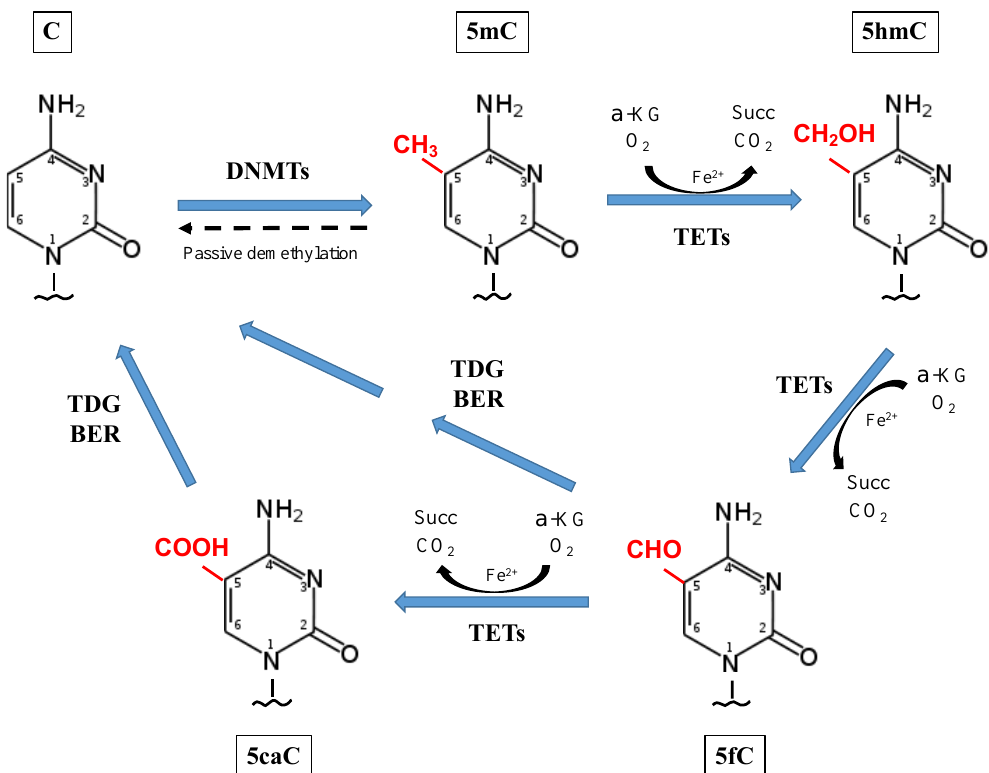
Figure 2. DNA methylation and demethylation in mammalian cells. DNA methylation occurs at the C5 position of cytosine (5mC), mostly in the context of CpG dinucleotides. 5mC is converted to 5-hydroxymethylcytosine (5hmC) by a DNA methylcytosine dioxygenase, belonging to the ten-eleven translocation (TET) family. TET proteins, including TET1, TET2, and TET3, can sequentially oxidize 5mC to 5hmC, to 5-formylcytosine (5fC), and finally to 5-carboxylcytosine (5caC), using oxygen, iron and α -ketoglutarate as co-factors / substrates. 5fC and 5caC are both repaired by base pair mismatch-mediated excision repair mechanisms (BER), thus resulting in conversion to cytosine, as part of an active process of demethylation. Alternatively, passive demethylation can occur during cell division.